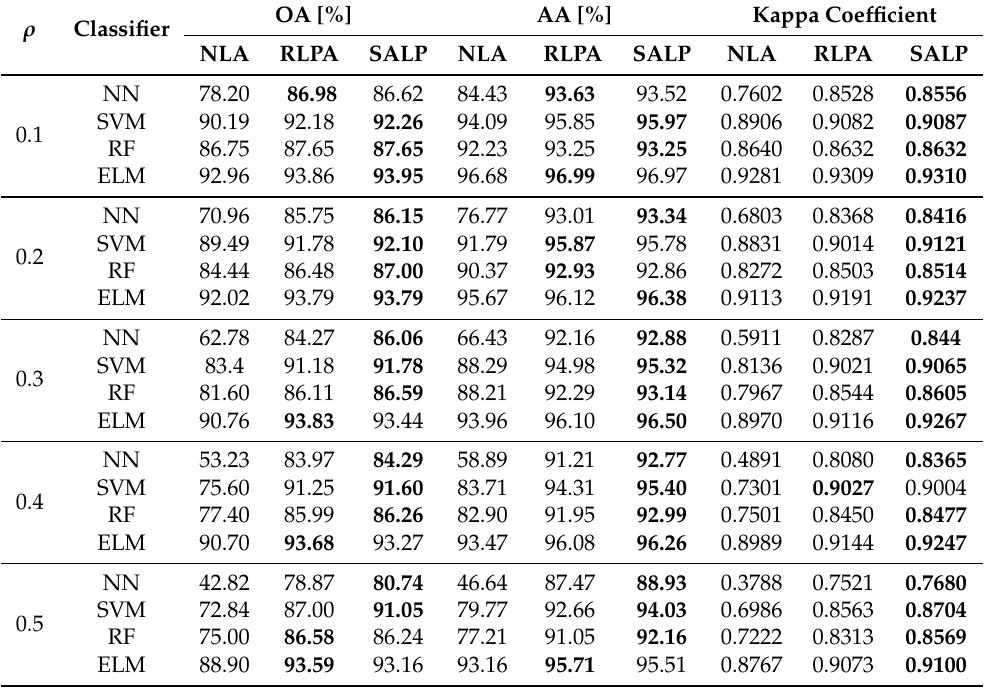
Table 4. Comparisons of baselines and SALP over four typical classifiers with the “both” Setting on the Salinas dataset. The best results are